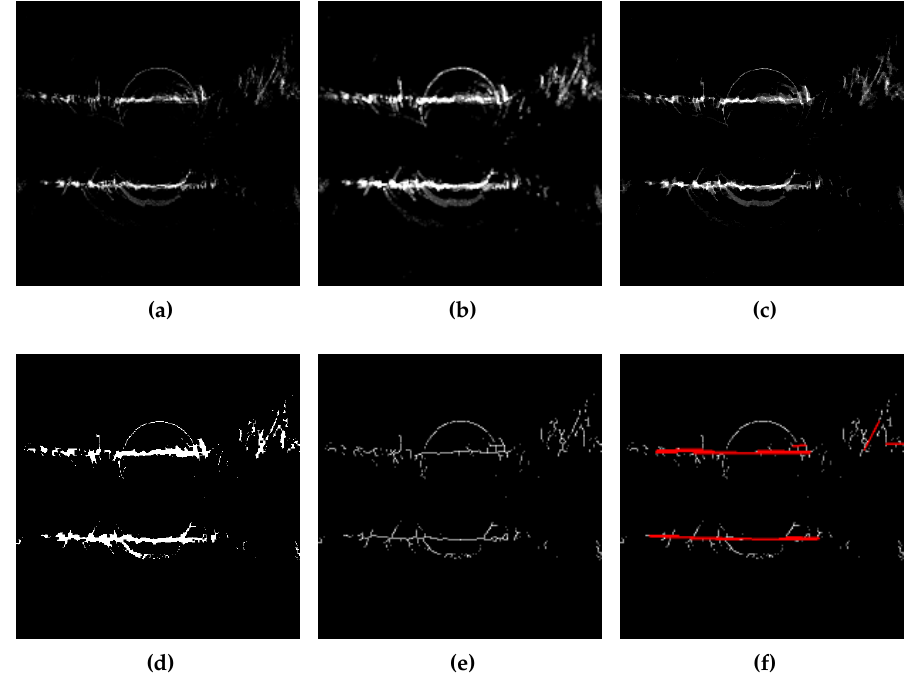
Figure 12. Processing applied to the computed ground map from the built 3D point cloud and segments detection by probabilistic Hough transform for the position Cap3/0900. ( a ) Ground print ( XY histogram); ( b ) Dilatation; ( c ) Erosion; ( d ) Binary threshold; ( e ) Thinning of Zhang and Suen; ( f ) probabilistic Hough